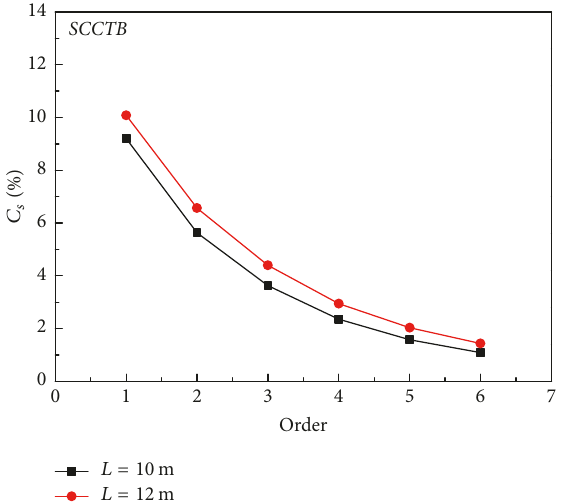
Figure 5: Relationship between the interface slip effect and the mode orders of natural vibration frequency.